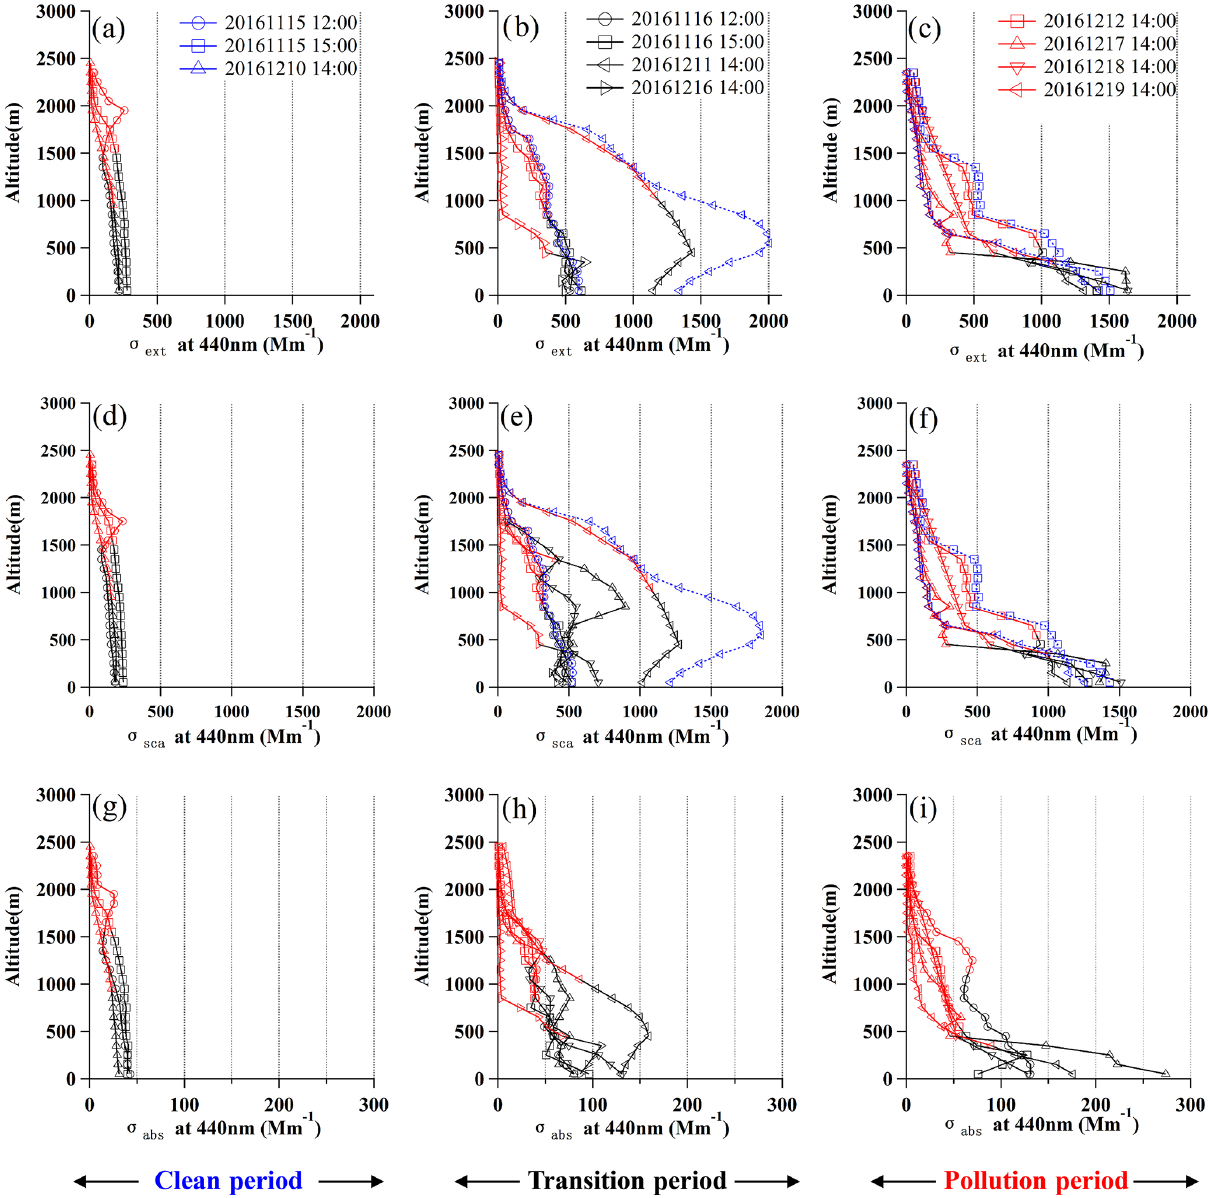
Figure 3. Vertical profiles of aerosol extinction, scattering and absorption coefficient at 440nm for CP (blue), TP (black) and HP (red), respectively. The black and red lines represent inside of and above the PBL, respectively. The hygroscopicity-corrected profiles are shown as blue